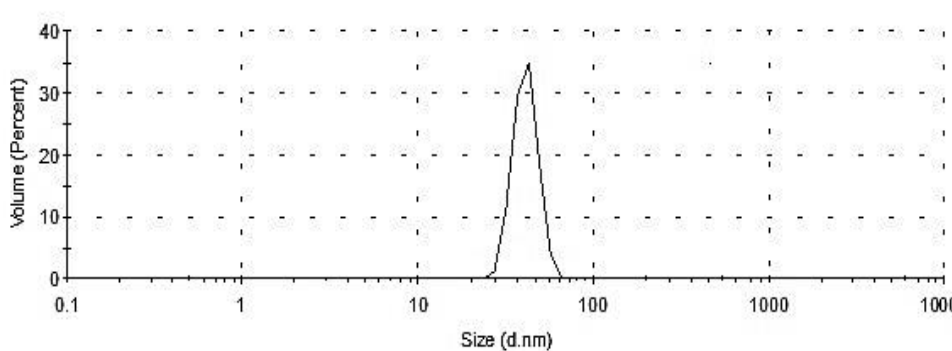
Antioxidants 2022 , 11 , x FOR PEER REVIEW Figure 4. DLS analysis of biosynthesized SiO 2 -NPs colloidal solution . Figure 4. DLS analysis of biosynthesized SiO 2 -NPs colloidal solution.